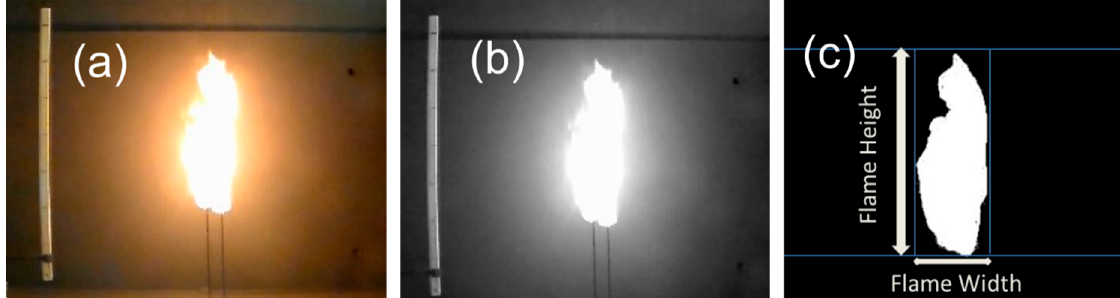
Figure 3. Schematic of image analysis. ( a ) Original colored image, ( b ) gray-scale image, and ( c ) black and white image showing the flame height and width measurements.